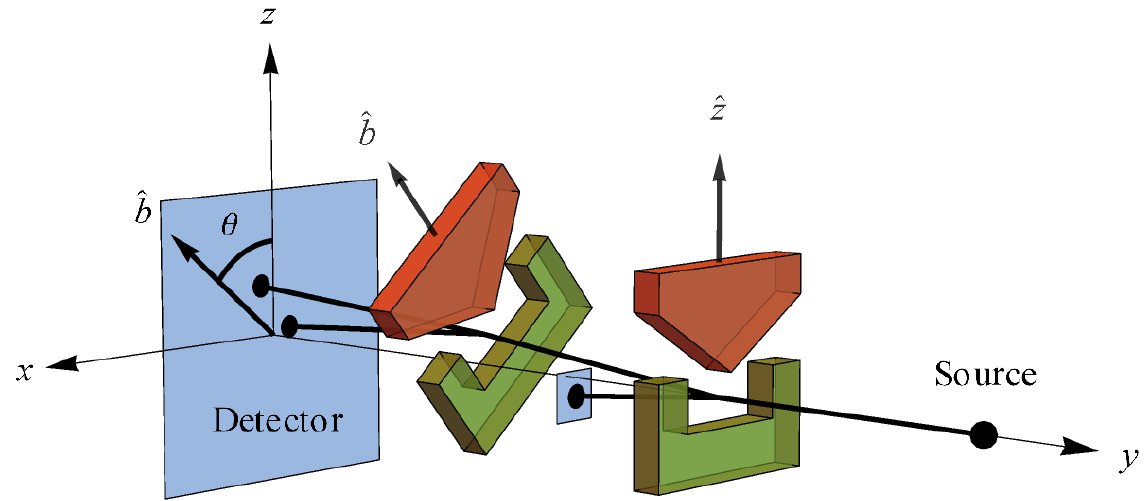
Figure 3: In this set up, the first SG magnets (oriented at ˆ z) are being used to produce an initial state | ψ ⟩ = | u ⟩ for measurement by the second SG magnets (oriented at ˆ b). Reproduced from Stuckey et al. [20].